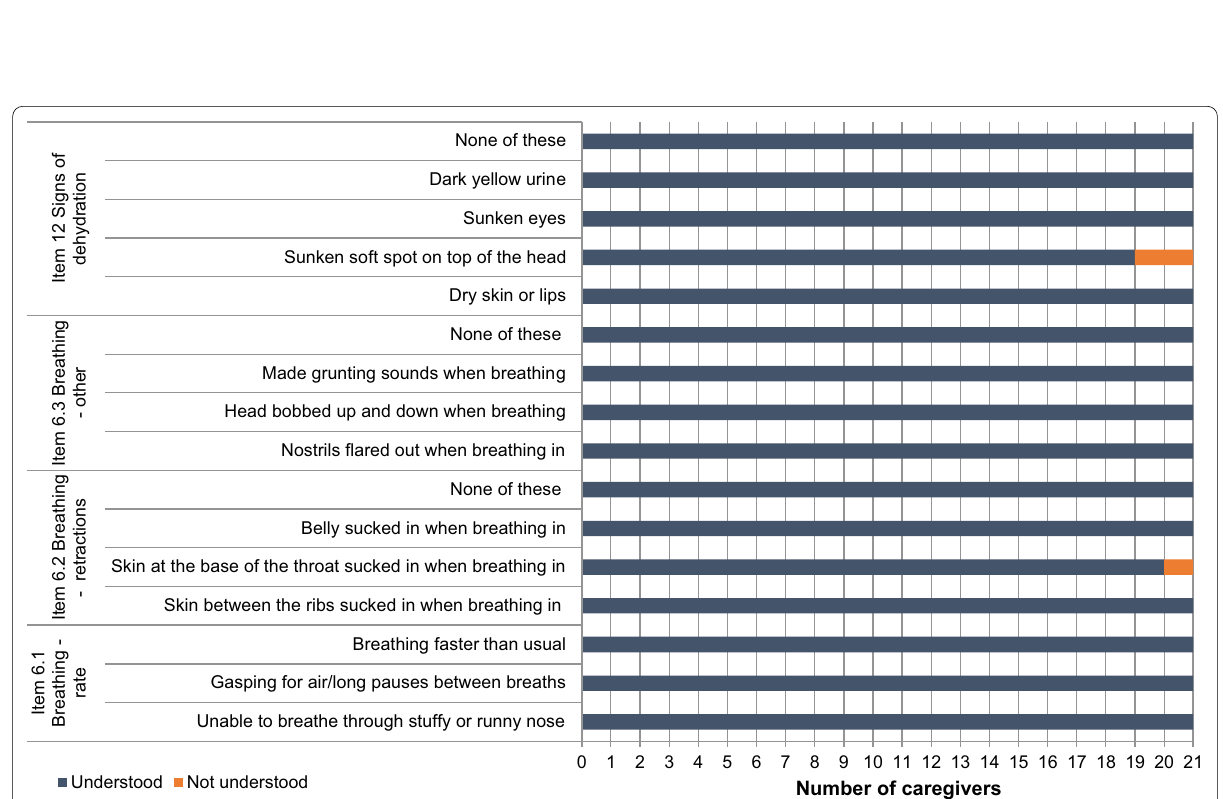
11]), the item not being discussed = 8]; =